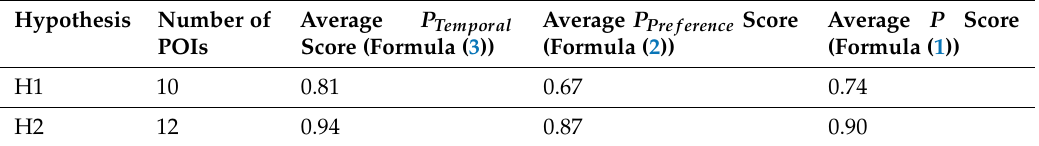
Table 1. Experiment